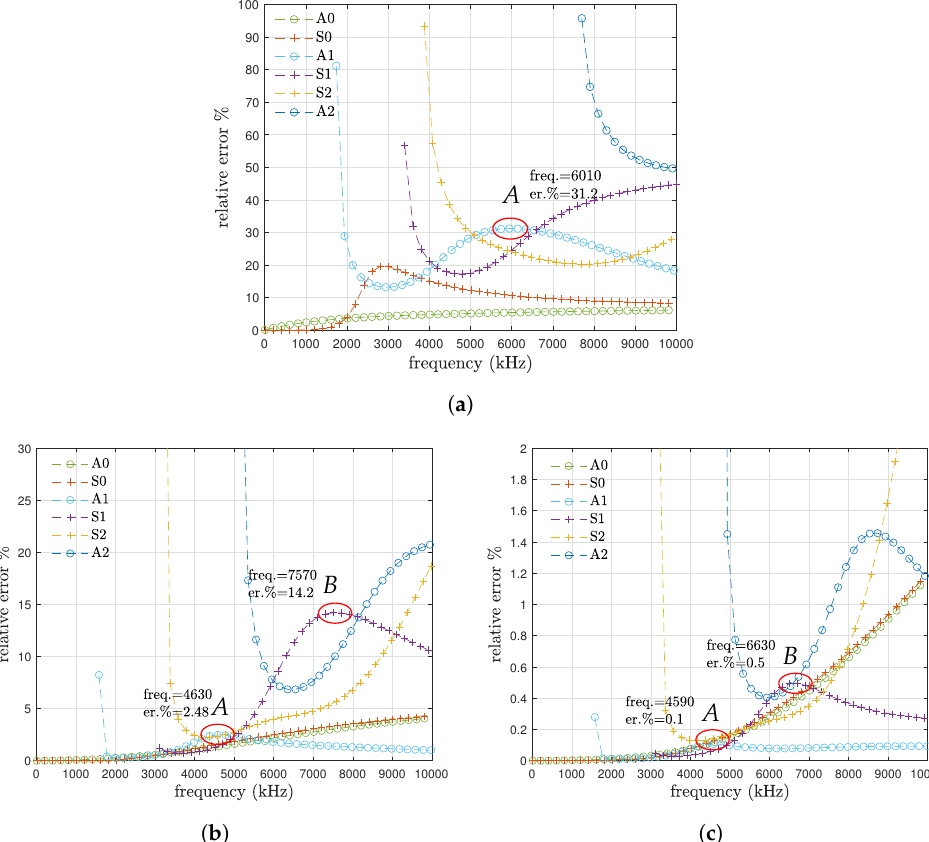
Figure 5. Calculated percentage error for the aluminum plate using FEM, ( a ) one element, ( b ) three elements, and ( c ) seven elements with 2nd order shape